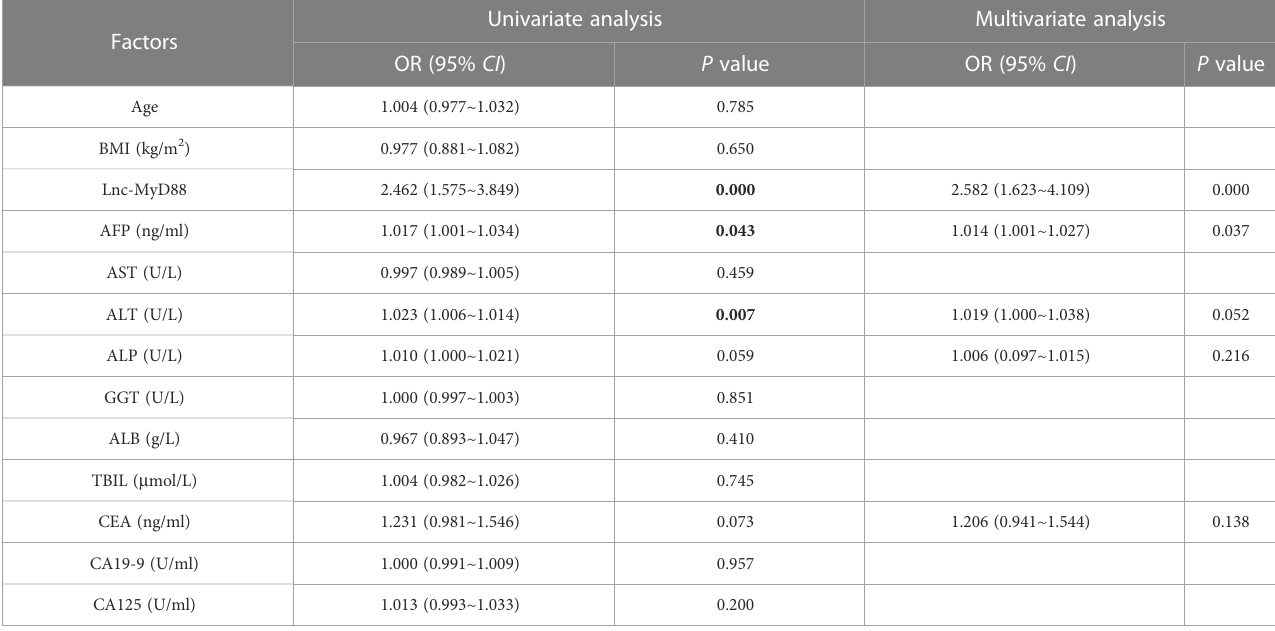
TABLE 6 The univariate and multivariate analyses indicated the diagnostic value of various clinical factors (including lnc-MyD88 and AFP) in HBV-related HCC group, and the healthy people group is the control.